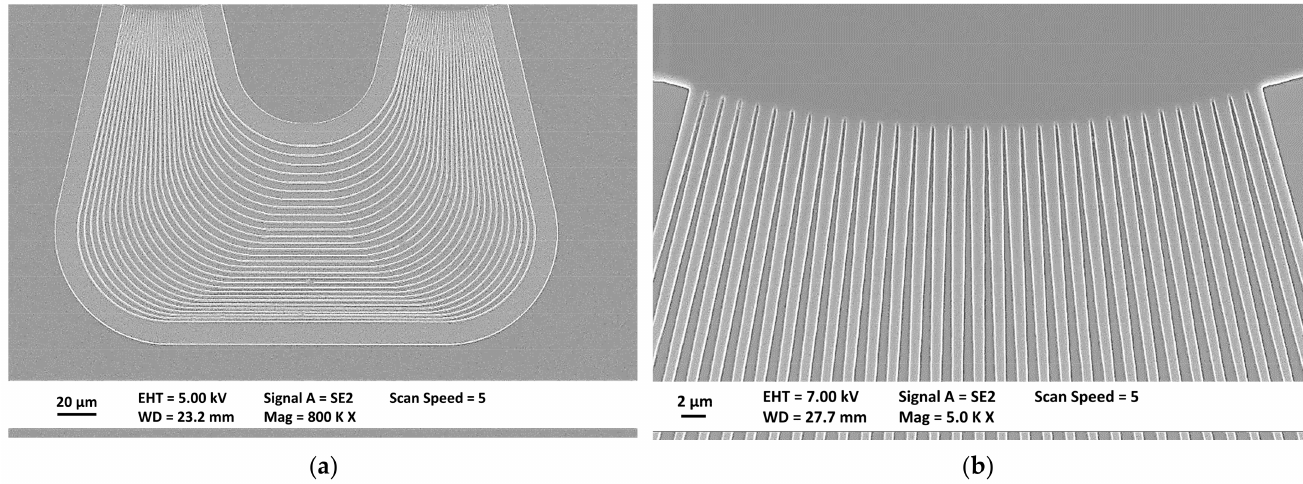
Figure 17. SEM images of etched structures reproduced in resist before etching and final SiO 2 cladding deposition: ( a ) arrayed WGs of AWG 100 GHz 1 × 4 optimized for 590 nm operation; ( b ) its output aperture